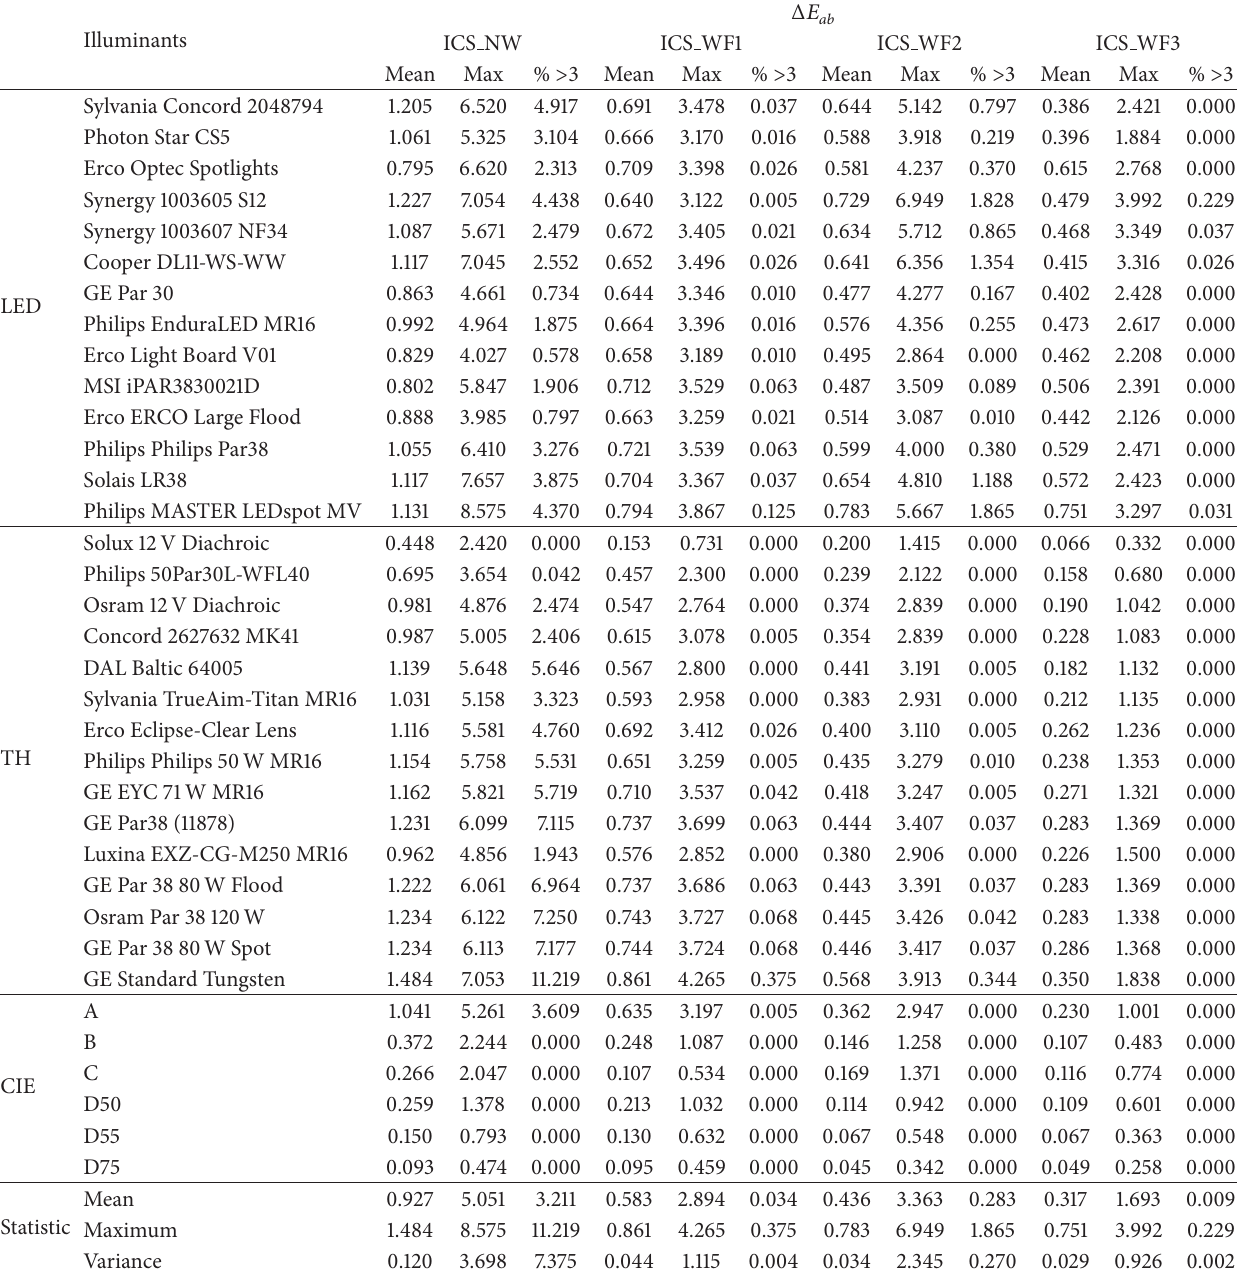
Table 3: Colorimetric representing accuracy comparison of the four ICSs with chips of Munsell and spectral image as training and testing sample, respectively.